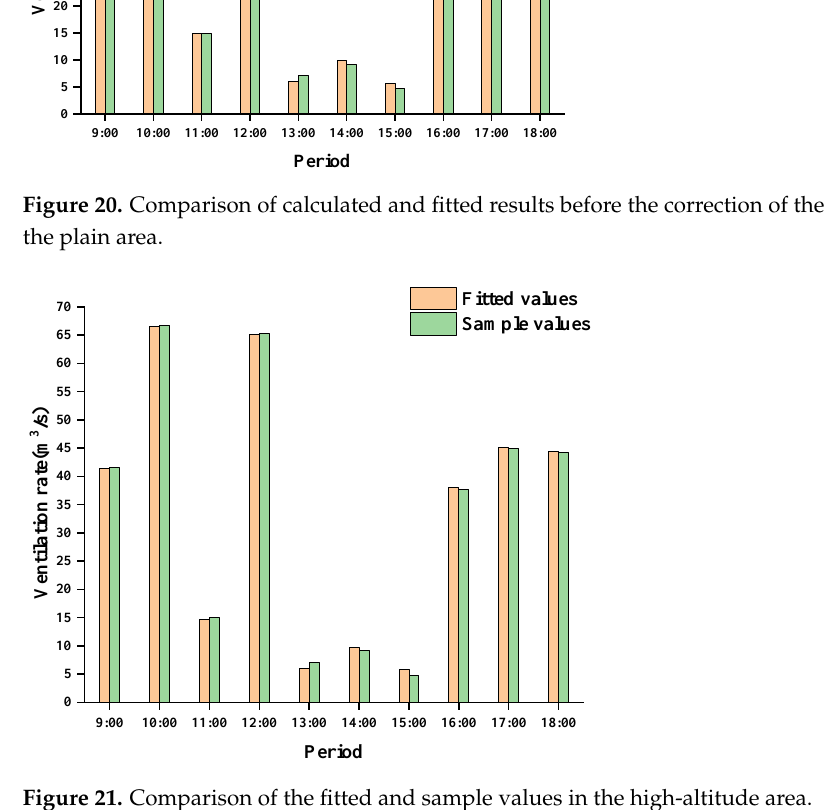
Figure 20. Comparison of calculated and fitted results before the correction of the ventilation rate in the plain area.